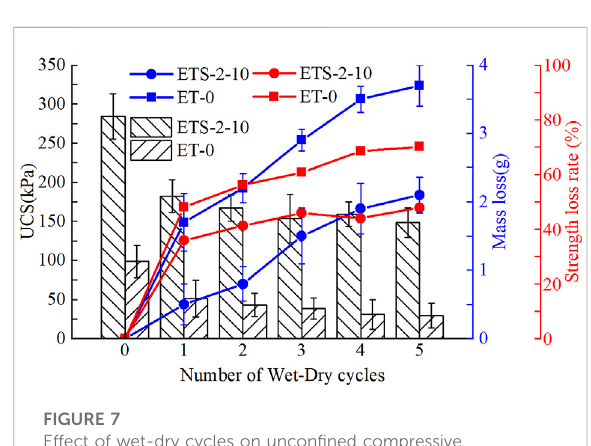
FIGURE 7 Effect of wet-dry cycles on uncon fi ned compressive strength, mass loss and strength loss